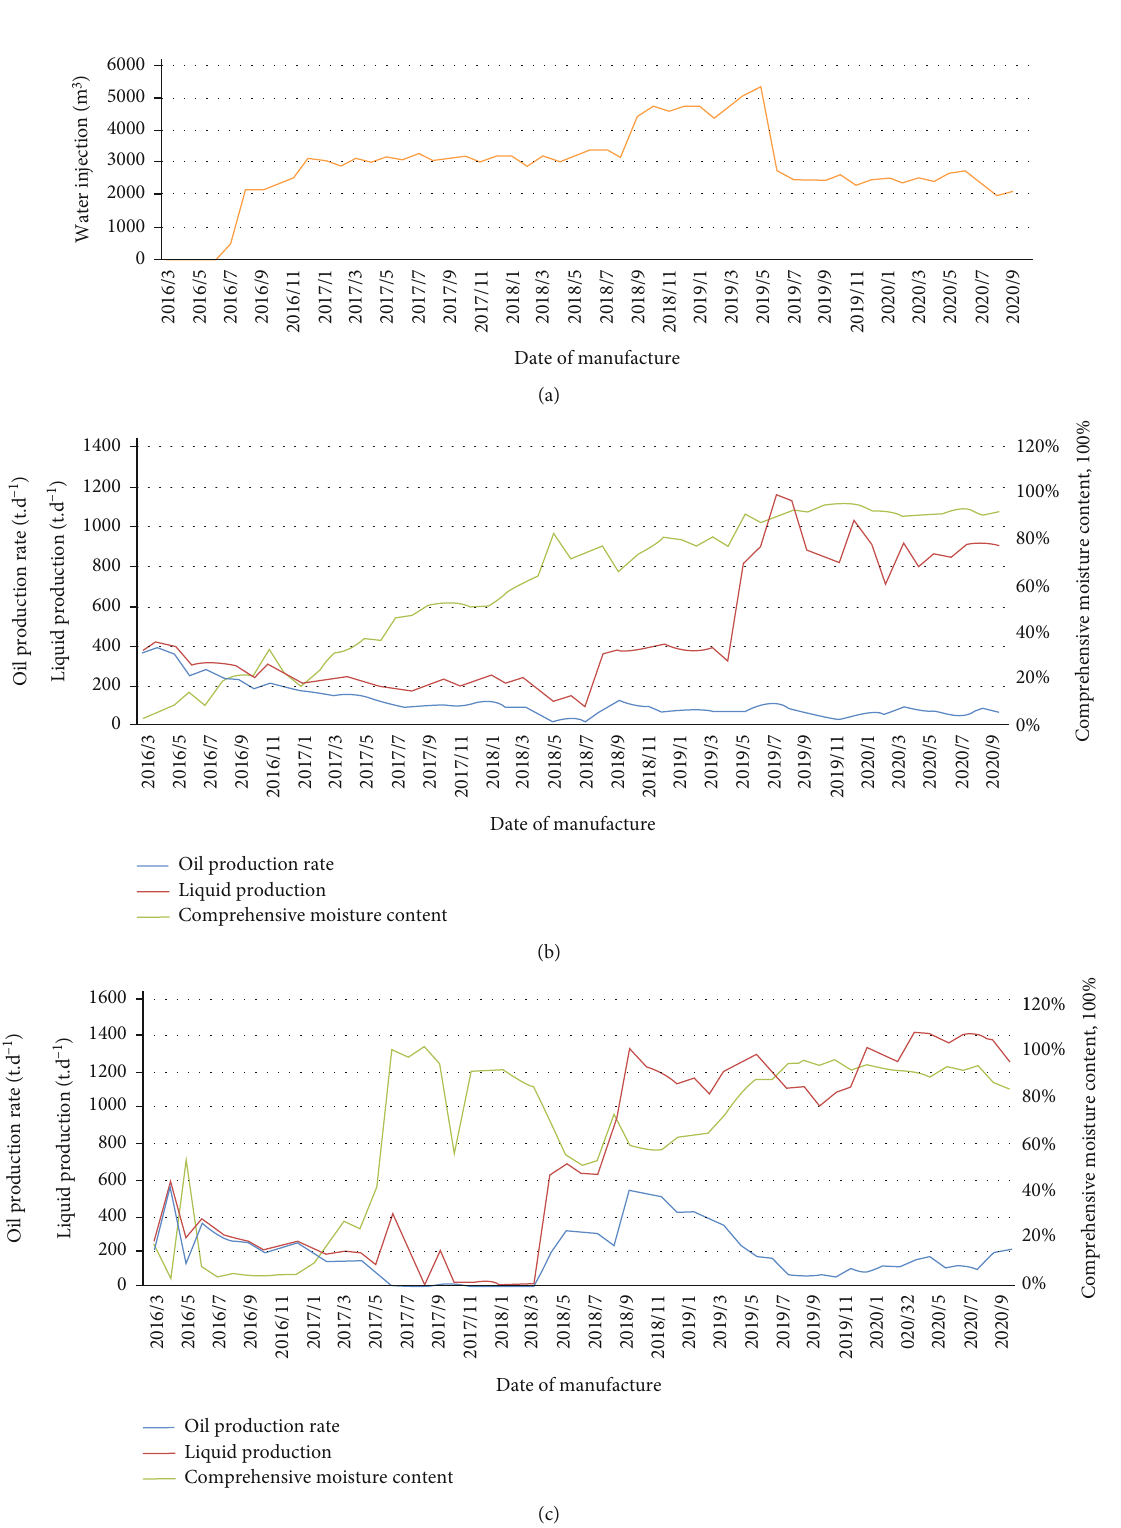
Figure 15: Dynamic response curve of NP12-177 well group in Nanpu 1-29 Area: (a) NP12-177, injection well; (b) NP12-173, production well; (c) NP12-174, production